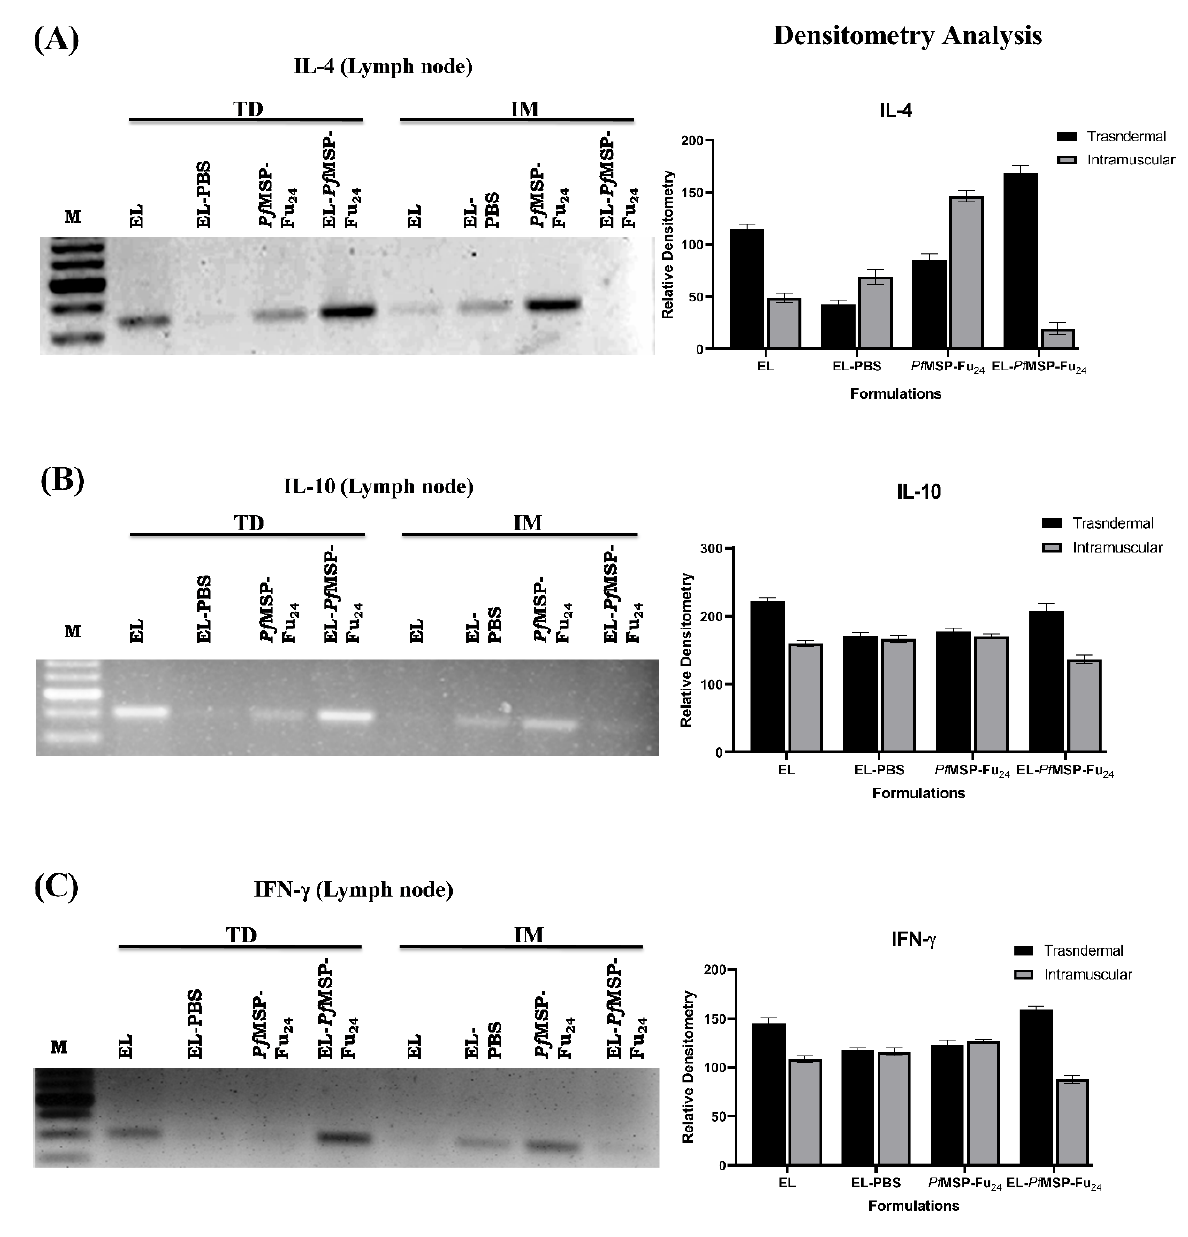
Figure 3. The expression analysis of ( A ) IL-4, ( B ) IL-10, and ( C ) IFN- γ by RT-PCR in the lymph nodes of BALB/c mice vaccinated with plain ( Pf MSP-Fu 24 ) and Pf MSP-Fu 24 -laden elastic liposomes (EL-PfMSP-Fu 24 ).